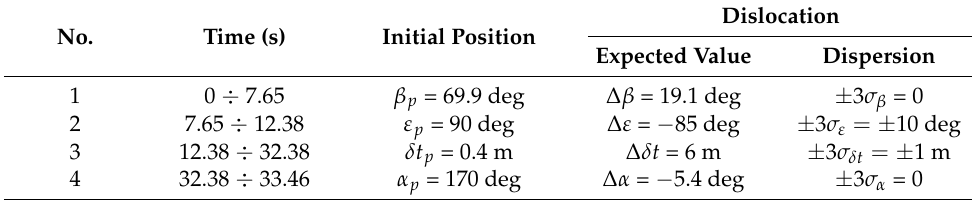
Table 1. Parameters of the working movements of the crane.